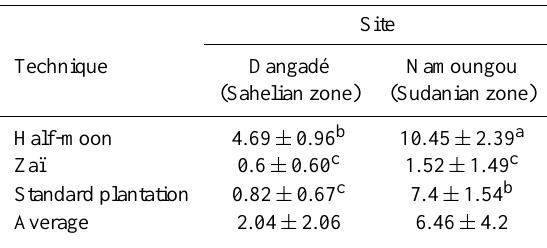
Table 1. Percentage of soil water content (average over all